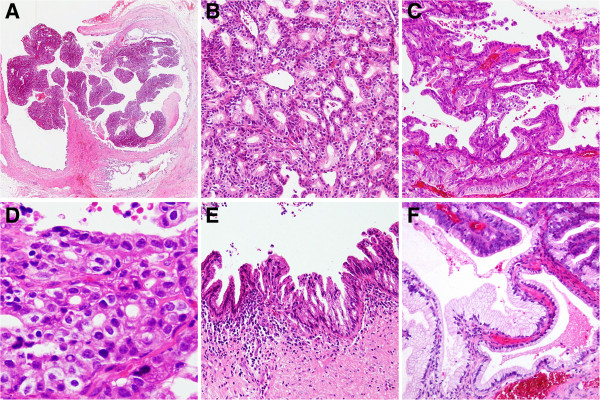
Microscopic findings of the pyloric gland adenoma and adjacent bile duct lesions. On microscopic view, the pyloric gland adenoma arose in the cystic duct (right) and displayed a papillary, intraluminal growth pattern with protrusion into the common bile duct (left) (A, H&E, x40). Closely packed pyloric type glands were lined by cuboidal to columnar mucus-secreting cells (B, x100) with focal architectural distortion (C, x100) and high-grade dysplasia with nuclear atypia, indicating transition into well-differentiated adenocarcinoma (D, x200). Focal high-grade intraepithelial neoplasia (BilIN-3) of the cystic duct was detected (E, x200), focally resembling gastric-type intraductal papillary neoplasm (IPN) with direct transition into the pyloric gland adenoma (F, x200).